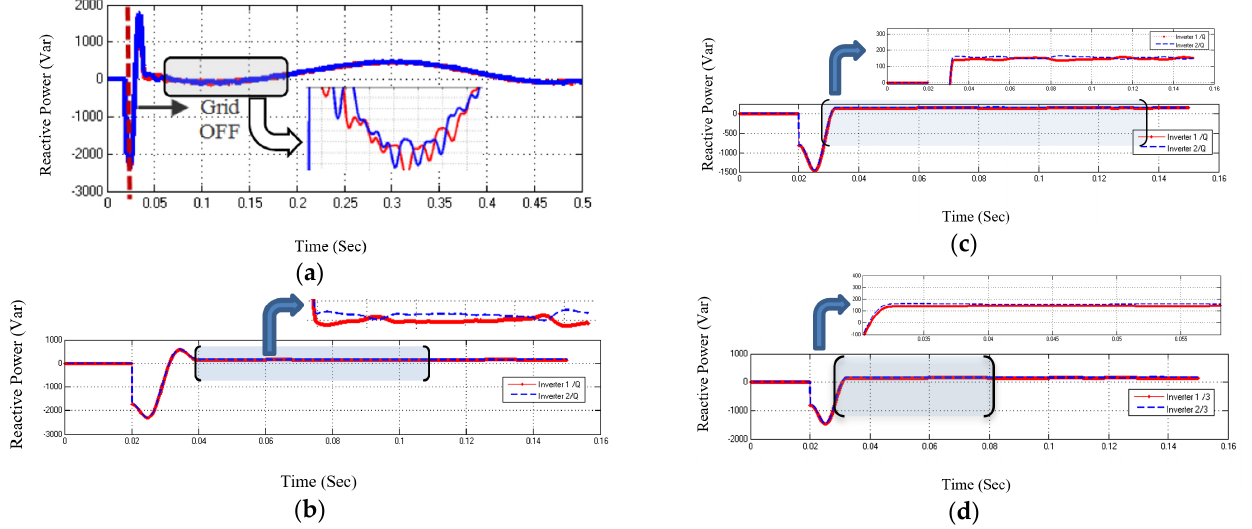
Figure 16. Reactive power sharing between inverter 1 and inverter 2 by droop control using: ( a ) Conventional control; ( b ) PSO algorithm; ( c ) ABC algorithm; and ( d ) H ∞ with ABC.